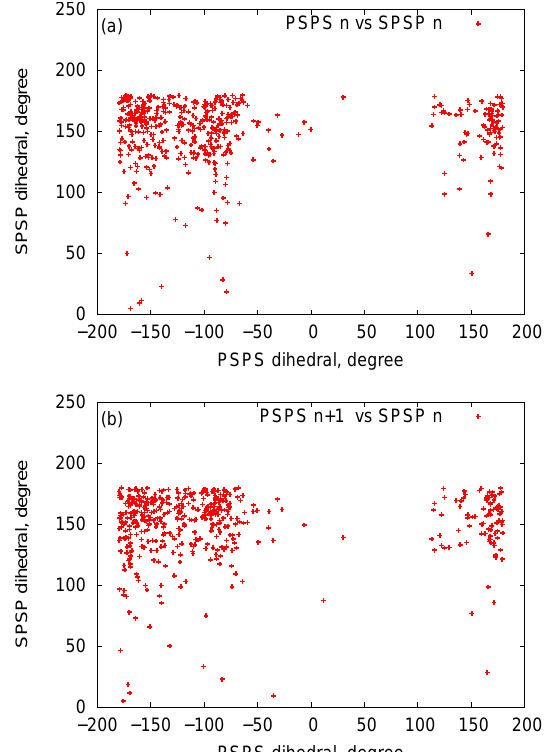
Figure 9. The two-dimensional map of the dihedral pair distributions of the RNA nanotube with two rings ( a ) Dihedral pairs centered around phosphate ( b ) dihedral pairs centered around